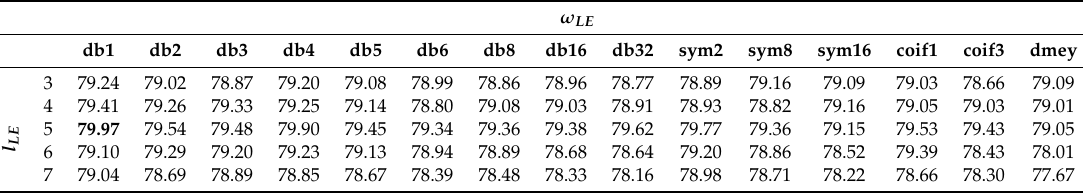
Table 24. The accuracy (%) of five class sleep stage classification with different ω LE and l LE under AASM